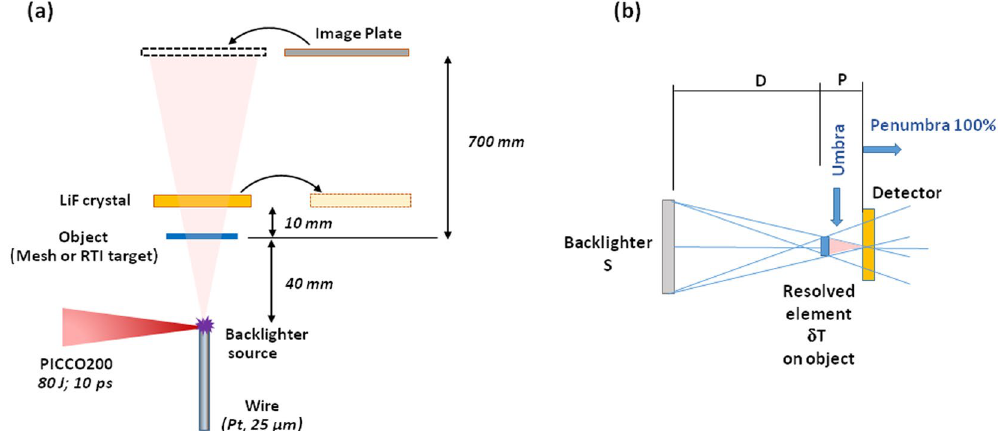
Figure 1. LULI2000 experimental setup: ( a ) The X-ray radiography scheme. ( b ) Schematic showing the geometrical limit on spatial resolution and the positioning of the detector.